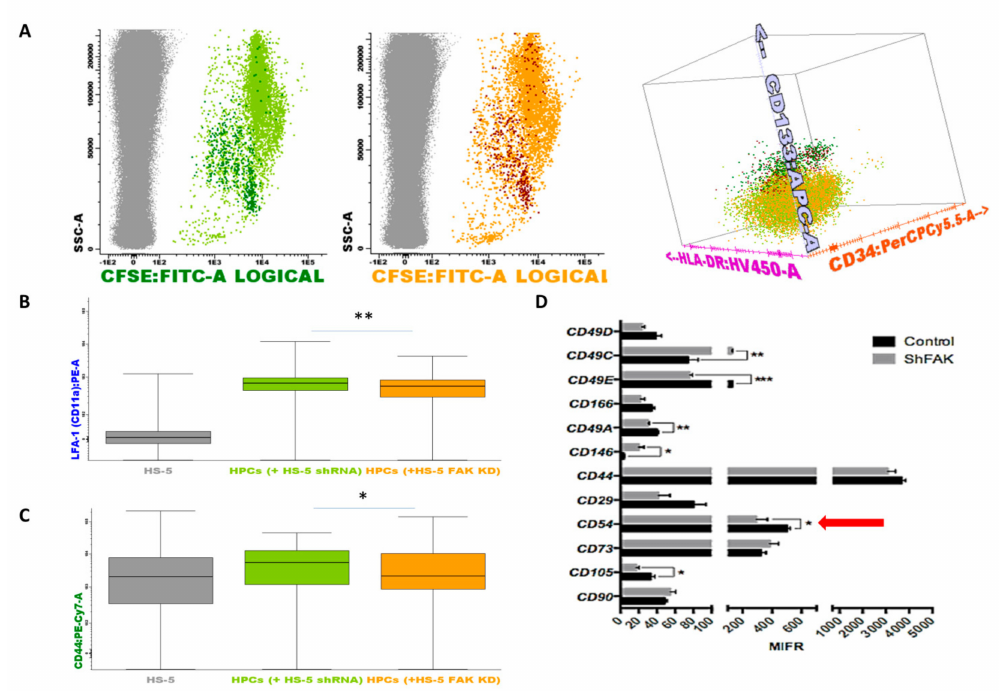
Figure 7. Upon FAK downregulation, the adhesion molecules profile is remodelled in HSPCs and stromal cells when co-cultured in direct contact. ( A ) HSPCs are discriminated from HS-5 cells based on their expression for CSFE (grey dots, non-haematopoietic HS-5 cells; dark green dots, CD133 + HSCs after direct contact with control shRNA cells; light green dots, more mature haematopoietic precursors after direct contact with control shRNA cells Figure 7A left; dark red dots, CD133 + HSCs after direct contact with FAK shRNA HS-5 cells; orange dots, more mature haematopoietic precursors after direct contact with FAK shRNA HS-5 cells Figure 7A middle). Discrimination of HSPC sub-populations based on the expression of CD133, CD34, and HLA-DR markers (Figure 7A right). ( B , C ) MFI values of LFA-1 (CD11a) and CD44 on more mature haematopoietic progenitor cells (grey, non-haematopoietic HS-5 cells; light green, HSPCs after direct contact with control shRNA cells; orange, HSPCs after direct contact with FAK shRNA HS-5 cells). Box plots represent the expression level of LFA-1(CD11a) and CD44 (n shRNA Control = 3, n HSPC + shRNA Control cells = 3, n HSPCs + shFAK KD cells = 3). Data were analysed in a merged file composed of three fcs files from HSPCs + shRNA control HS-5 cell co-cultures and three fcs files from HSPCs + shRNA FAK KD HS-5 cell co-cultures. The upper and lower hinges of the box indicate the 75 th and 25 th percentiles of the data set. The median line within the box represents the median value of the intensity of expression. The whiskers indicate the minimum and maximum data values. ( D ) MFI values of several adhesion molecules evaluated on FAK shRNA HS-5 cells by flow cytometry. p < 0.05(*); p < 0.01(**); p <